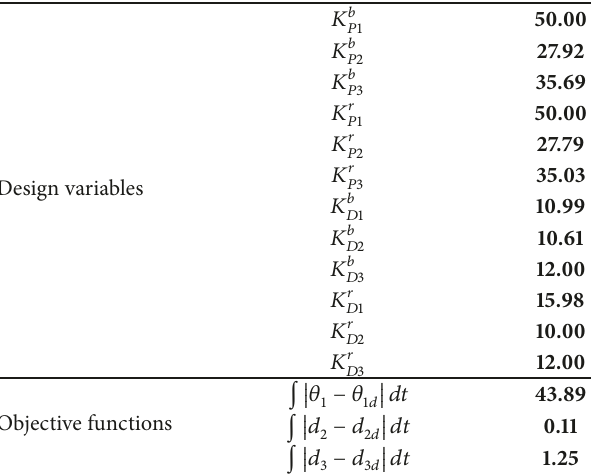
Table 5: Design variables and objective functions found by the particle swarm optimization